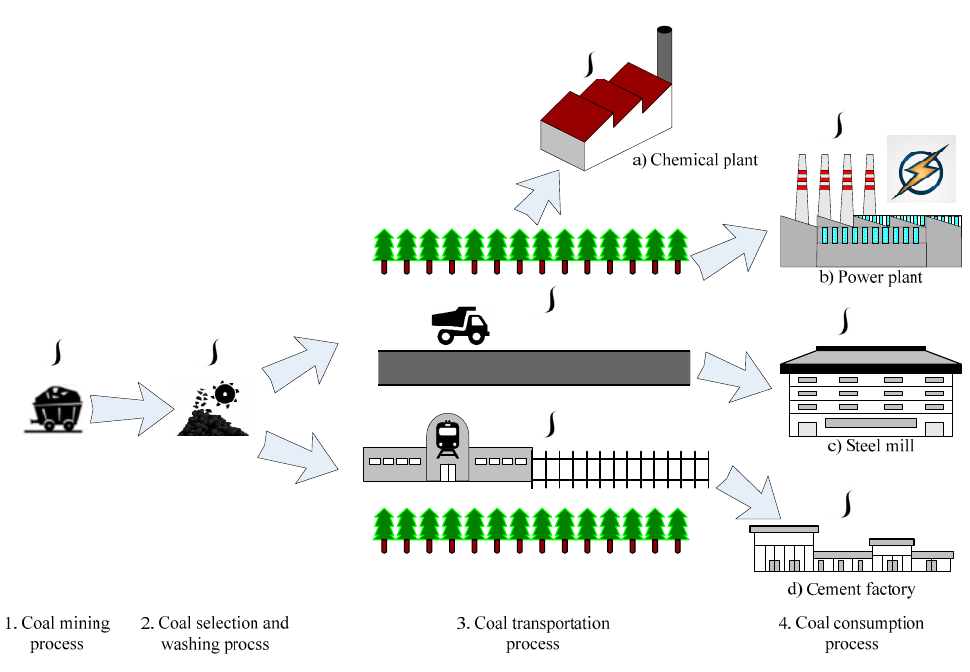
Figure 2. Coal supply chains in Wu’an.